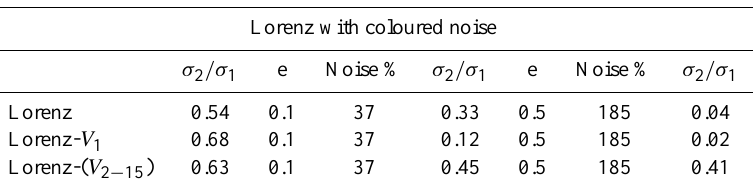
Table 1. This Table presents the ratio σ 2 /σ 1 estimated for the original Lorenz system, the stochastic (coloured noise) Lorenz system and the SVD components of the stochastic Lorenz system Lorenz with coloured noise σ 2 /σ 1 e Noise %